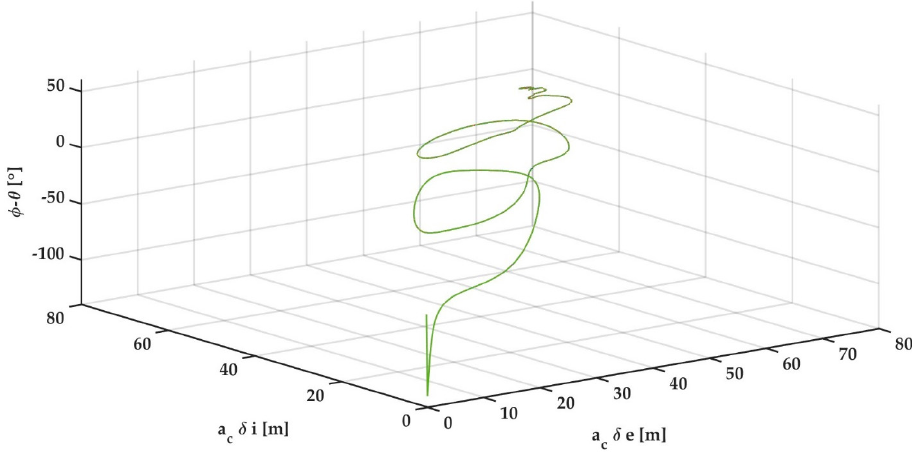
Figure 9. Safe condition evaluation for follower 1—chief formation. 5. Constellation of Formations.